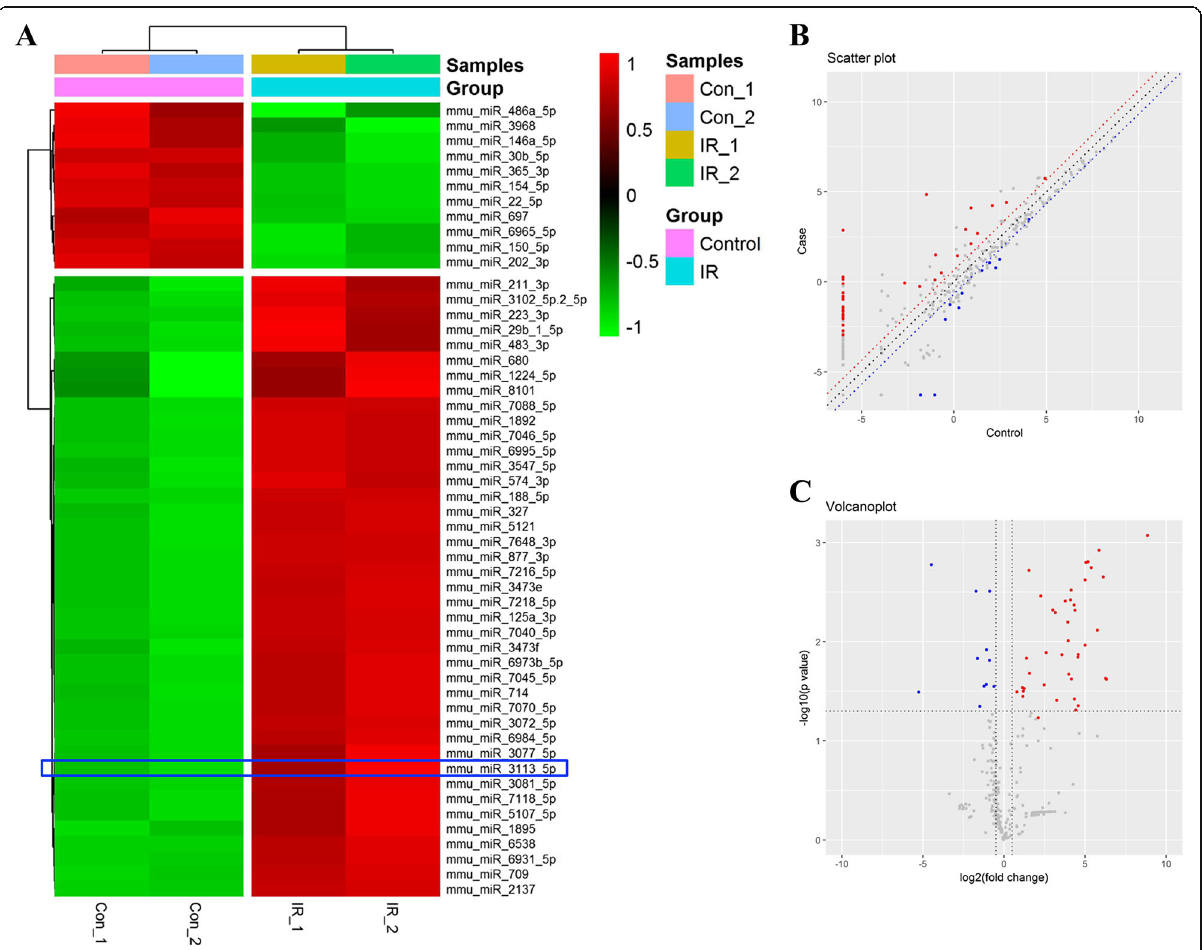
Fig. 2 microRNA array analysis of heart tissues at 3 h after I/R injury. a Heatmap of the microRNAs that showed significant alteration between control (sham group) and I/R injury mice. b-c Scatter plot and volcano plot for all the identified